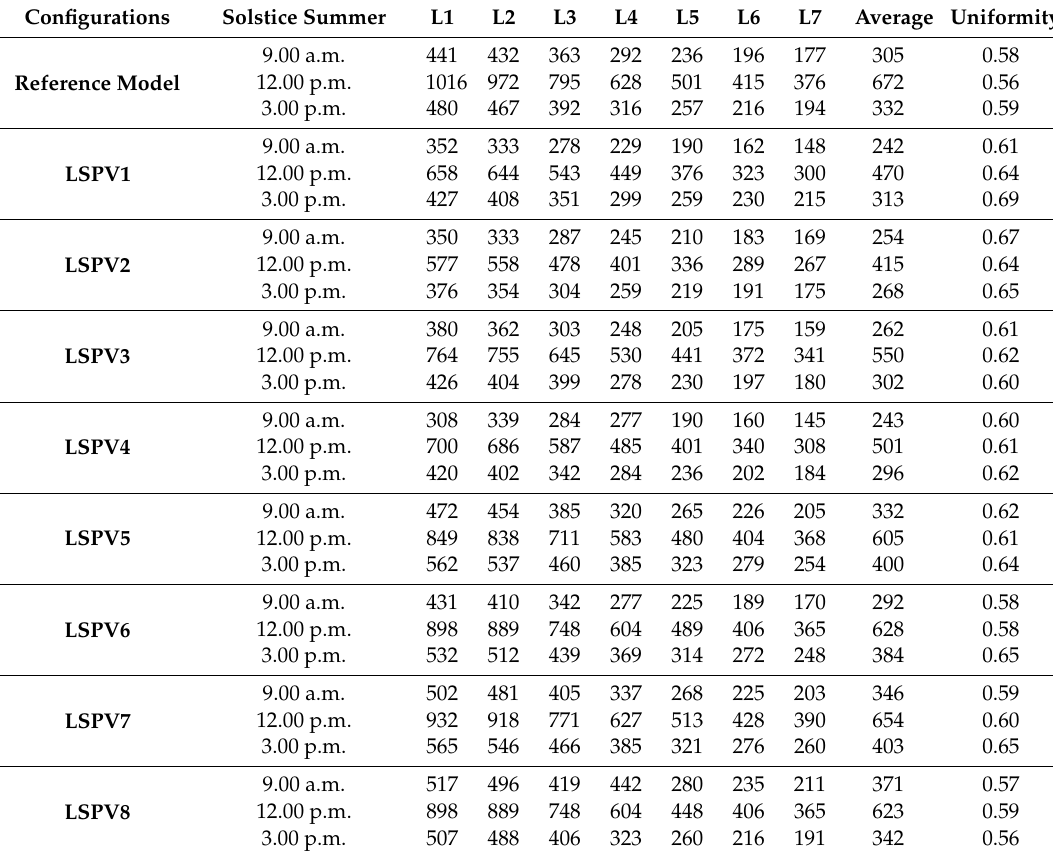
Table 7. ThepointintimeilluminanceofPVintegrationwithlightshelvesanduniformityatsolsticesummer. Configurations Solstice Summer Reference